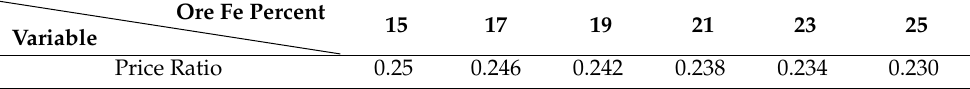
Table 2. Model 3 (cid:48) s fluctuating price ratios per decrease in Fe Content.